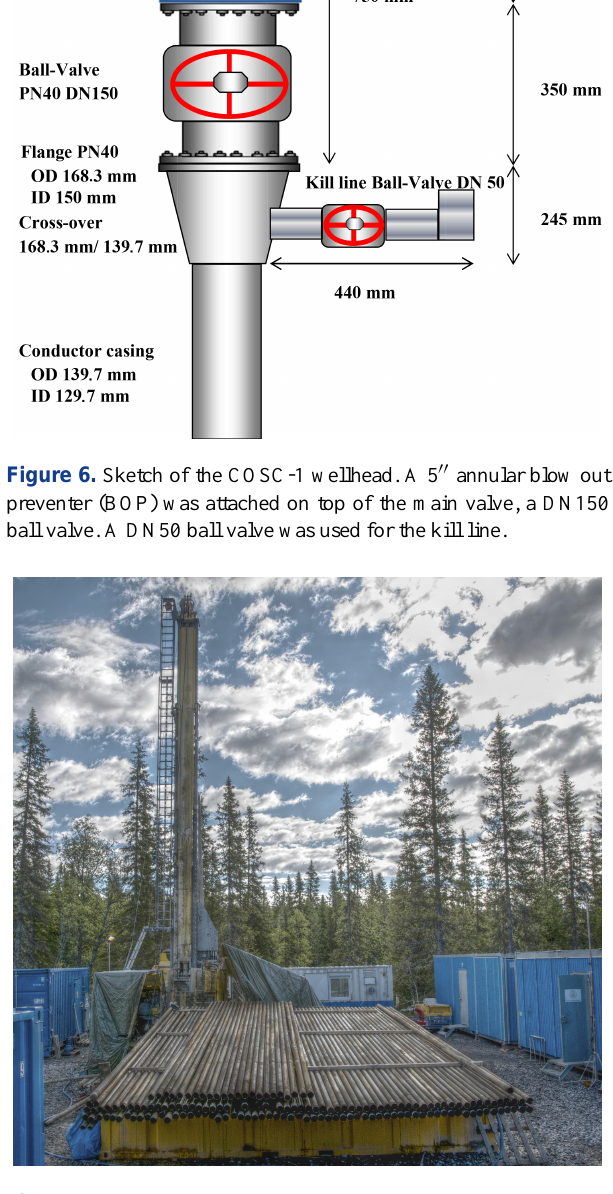
Figure 7. The Swedish national research infrastructure for sci- entific drilling, “Riksriggen”. An Atlas Copco CT20C crawler mounted drill rig with a manual pipe handling system mounted on top of the mud tanks, with ca. 1400m of HRQ drill pipe in this